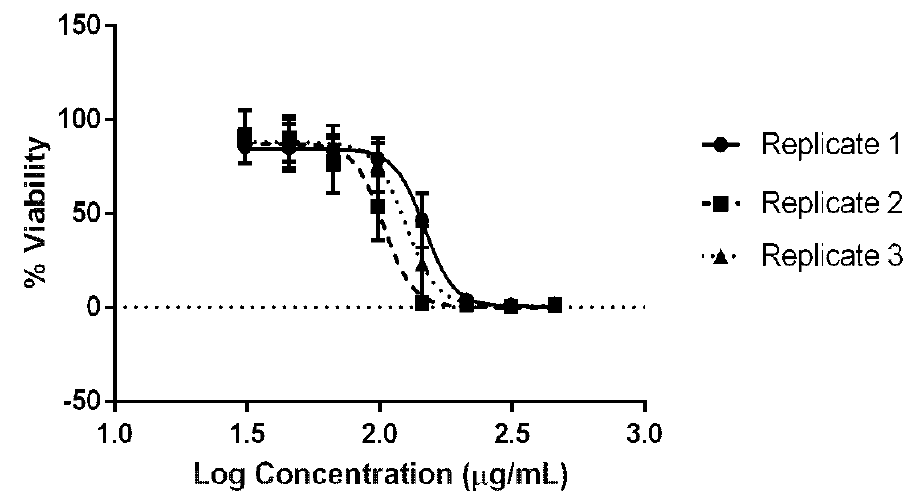
Figure 4. Cytotoxicity evaluation of the AgNPs biologically synthesised by the fungus C. thermophilum : the AgNP dose – response curves (Hill function fit) of the NRU assay using the skin fibroblasts from the murine embryo Balb/c 3T3 NIH cell line.